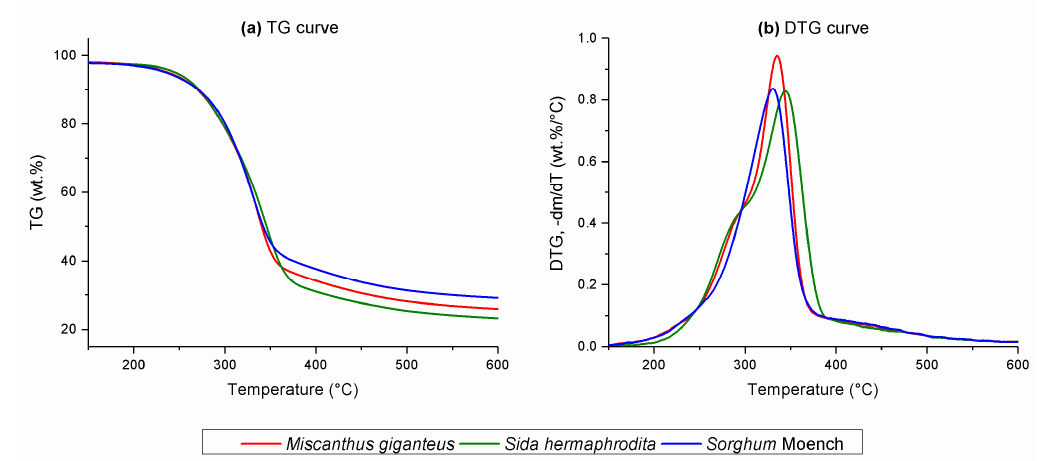
Figure 1. ( a ) Thermogravimetric (TG) and ( b ) derivative TG (DTG) curves for energy crops at a heating rate of β = 10 ◦ C /min.